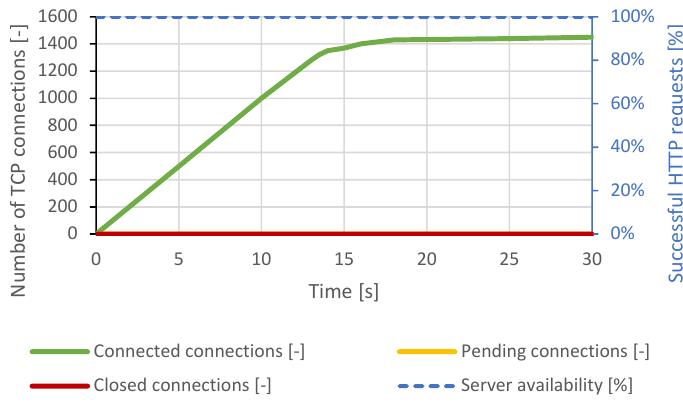
Figure 12. SlowDrop attack against Nginx server.